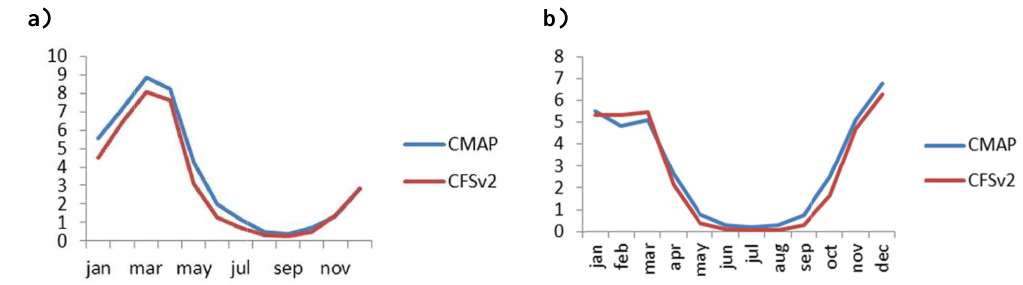
Fig. 1. Annual cycle of total rainfall (mm) for the two grid boxes defined over NEB region: (a) to the north; (b) to the south.